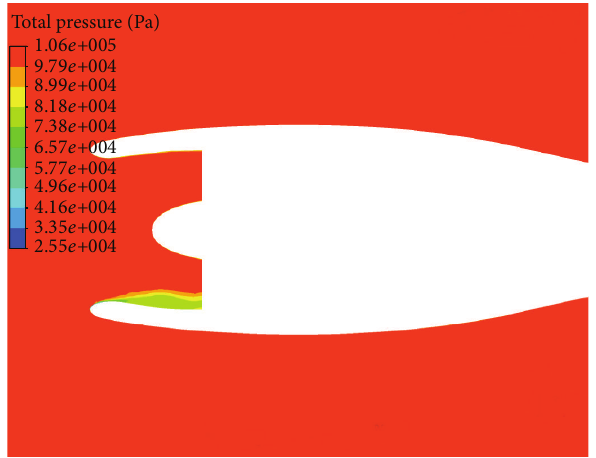
Figure 20: Contours of the total pressure obtained by the AD at the last iteration.